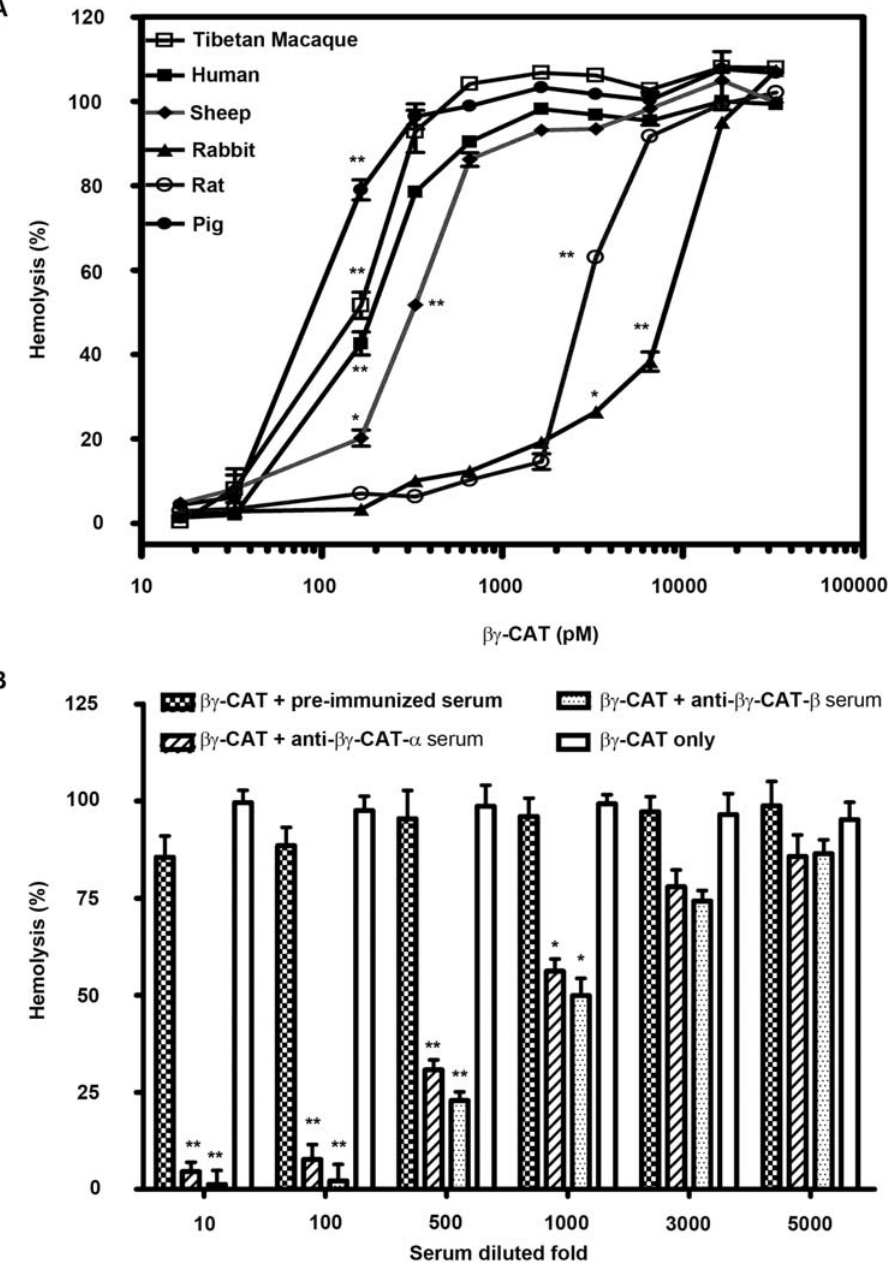
Figure 4. Hemolytic activity of bc -CAT and antibody neutralization. (A) Hemolytic activity of bc -CAT on mammalian erythrocytes. The erythrocytes (5 6 10 6 cells/ml) of different species were incubated with various concentrations of bc -CAT at 37 u C for 30 min, and hemolytic activity was determined as described in ‘‘Methods’’ (B) Neutralization of bc -CAT hemolytic activity by specific antiserum against each subunit of the protein. bc -CAT (3 nM) was incubated with a series of diluted rabbit antiserum against each subunit at 37 u C for 30 min, and then the rest of the hemolytic activity on human erythrocytes was determined. Pre-immunized serum was used as a negative control. The value for the erythrocytes lysed with 0.1% Triton X-100 was taken as 100%. Data were expressed as means 6 SEM of triplicate measurements (*, p , 0.05; **, p , 0.01, compared with zero bc -CAT (A) or compared with the bc -CAT only group (B). In (A), only initial point ( p , 0.01) was marked (**) and the following points that all have p , 0.01 were omitted for